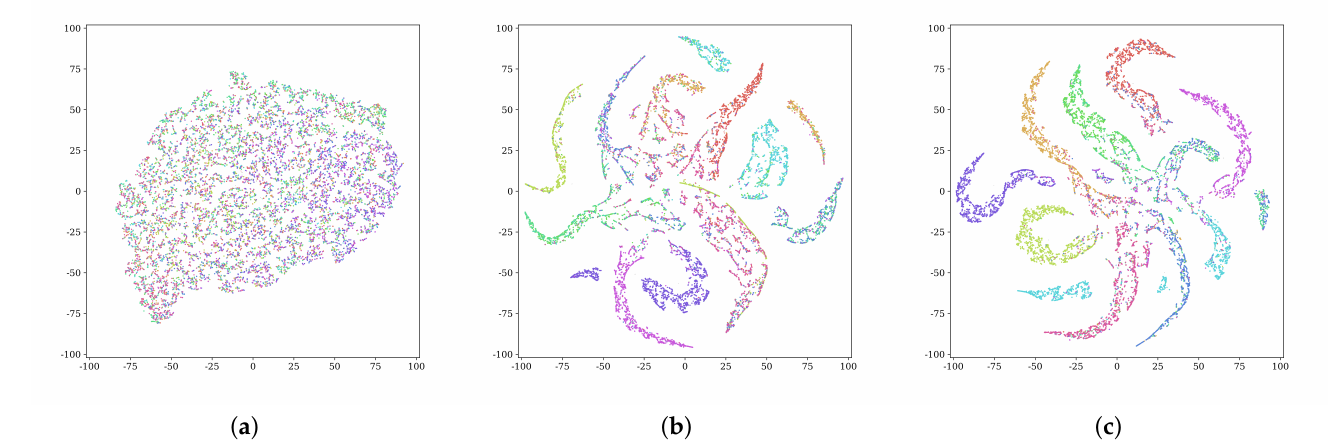
Figure 3. Visualization of the class − level representations for different training stages of the proposed DCSM on the Imagenet10 datasets. ( a ) Initial stage of DCSM, ( b ) Middle stage of DCSM and ( c ) Final stage of DCSM.